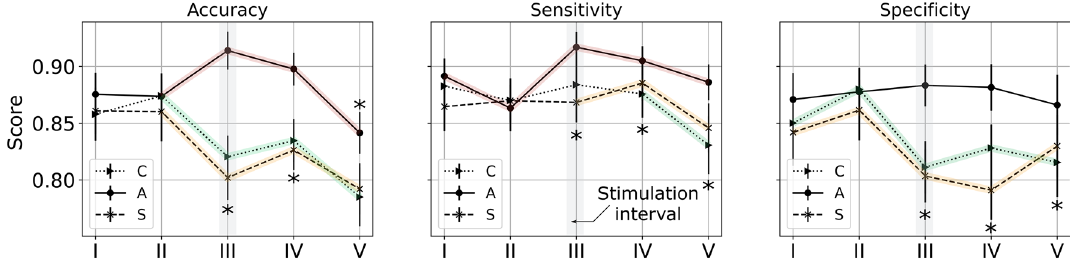
Figure 2. Trends in task performance for each phase as represented by the mean value and its standard error for each condition (control, anodal, and sham tDCS). The shaded segments represent consecutive time points where a statistically significant effect of time was found; the asterisk presents time points (phase) where a significant effect of condition was